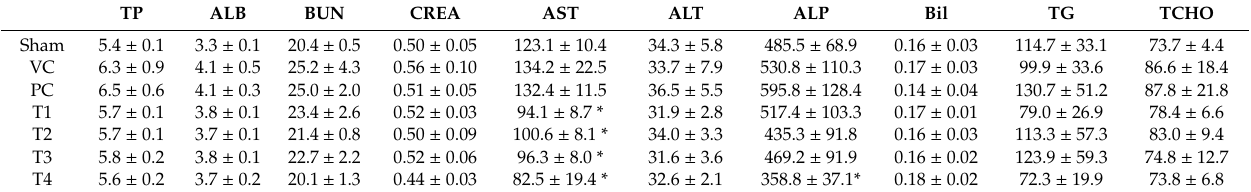
Table 1. Serum biochemistry data at necropsy for all experimental groups of